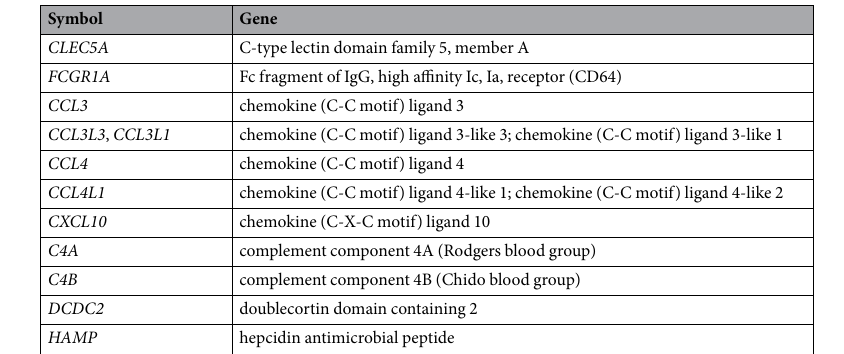
Table 1. Genes contained in up-represented terms in Gene Ontology analysis (Biological